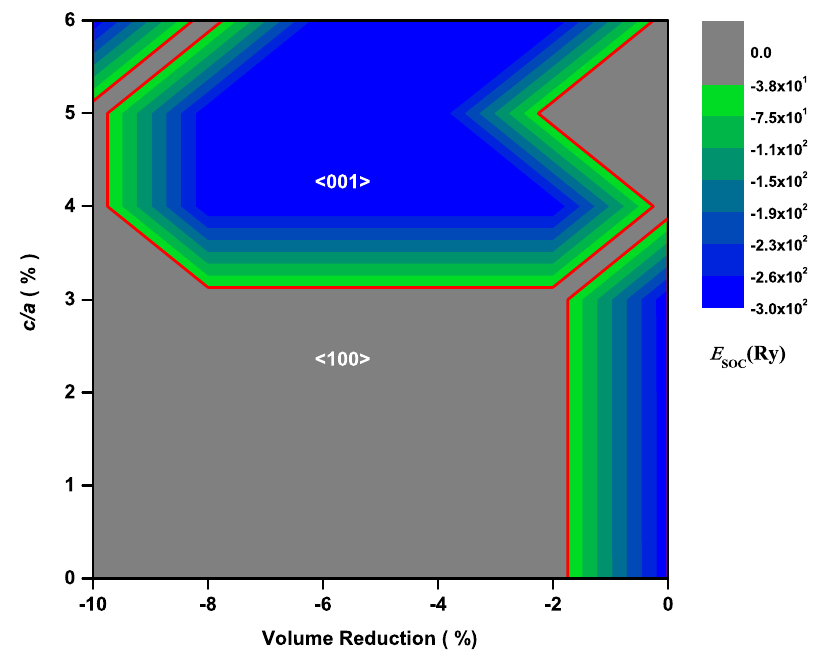
Figure 6. E SOC for the CeAuSb 2 compound. The thick red curve corresponds to E SOC = 0, i.e., the phase boundary between the easy axis along the < 100 > and < 001 >